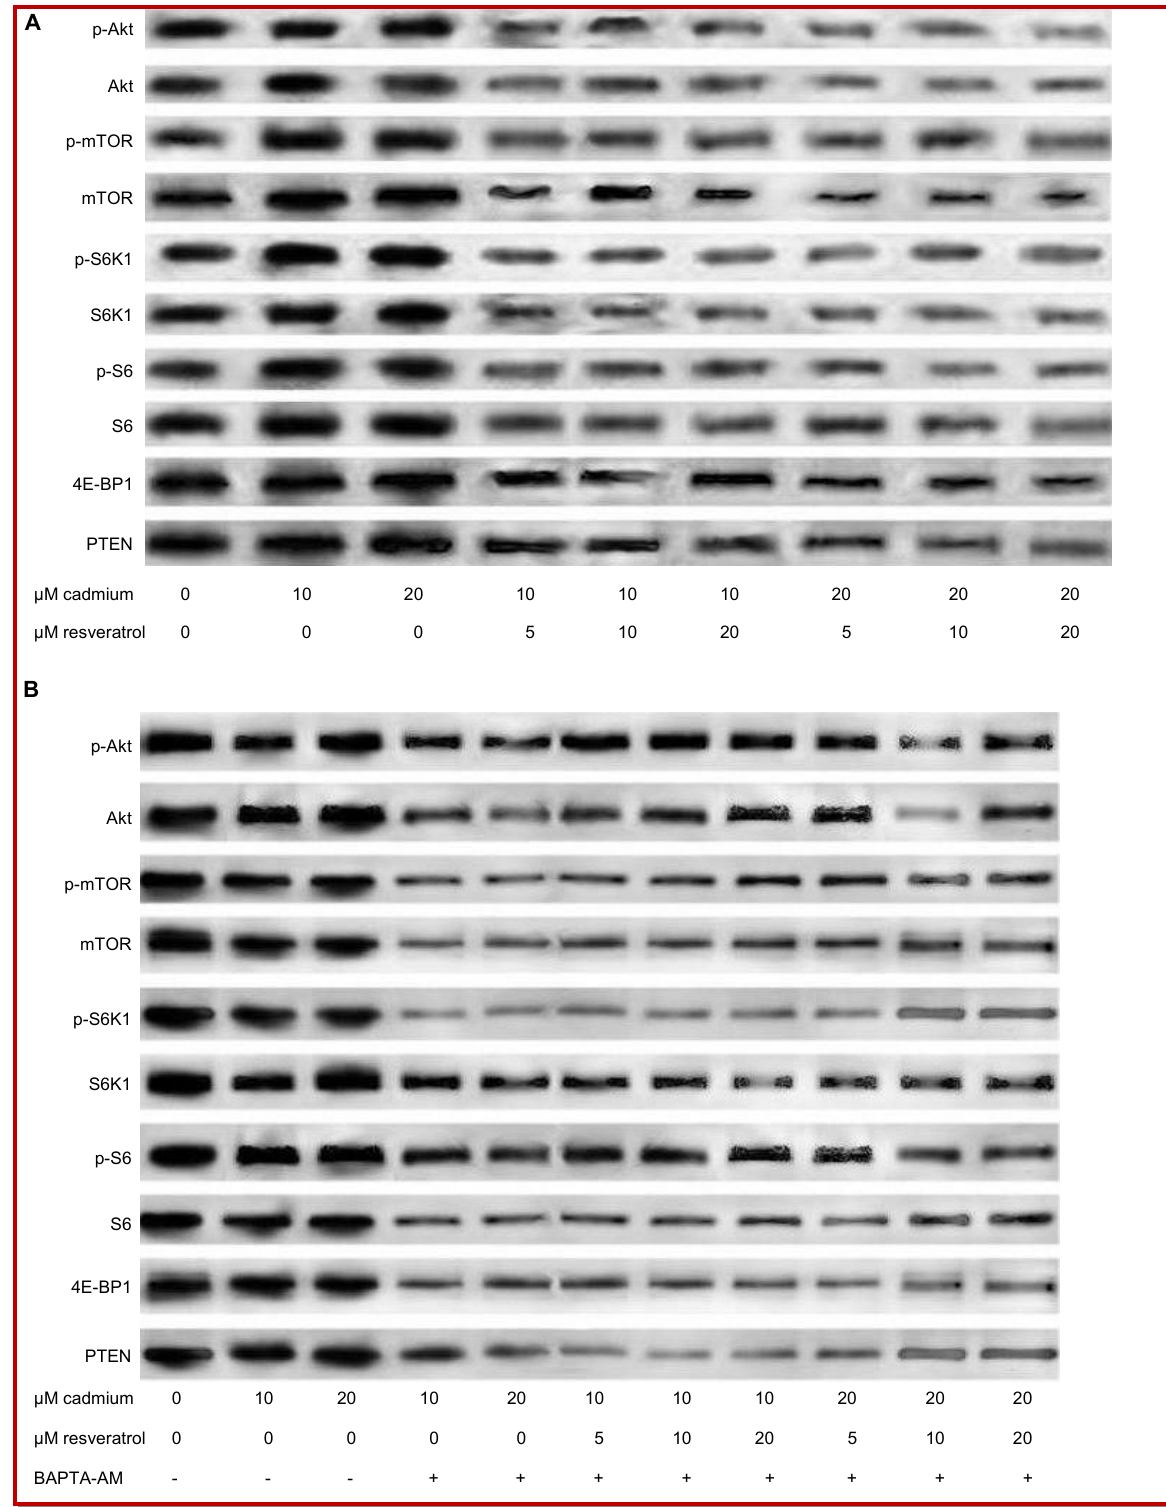
Figure 5: Resveratrol regulates the expression of MAPK pathway